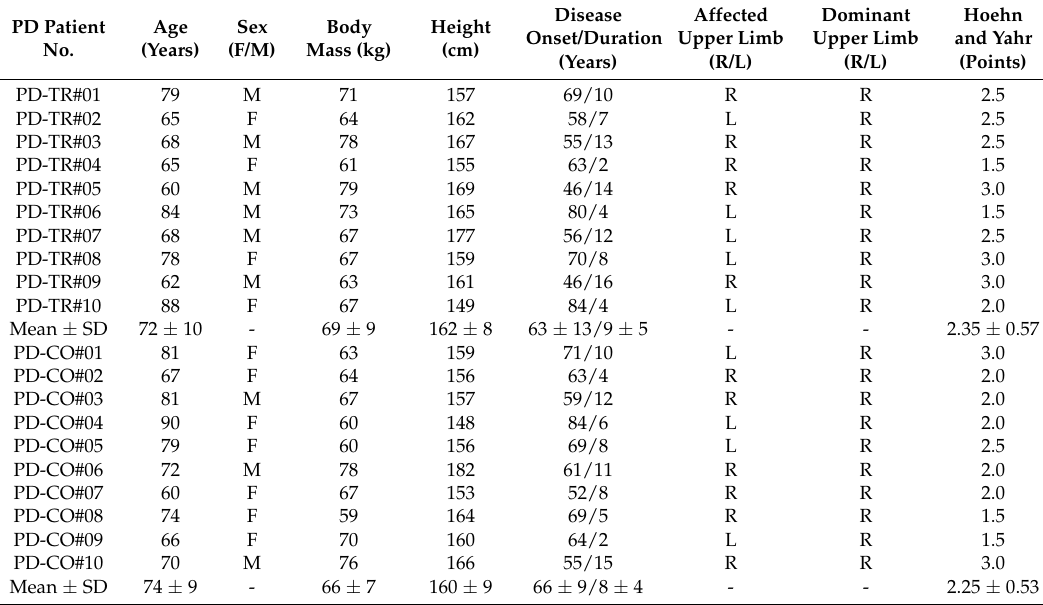
Table 1. Clinical and anthropometric characteristics of the Parkinson’s disease (PD) patients in the training (PD-TR, n = 10) and control (PD-CO, n = 10) groups. PD Patient